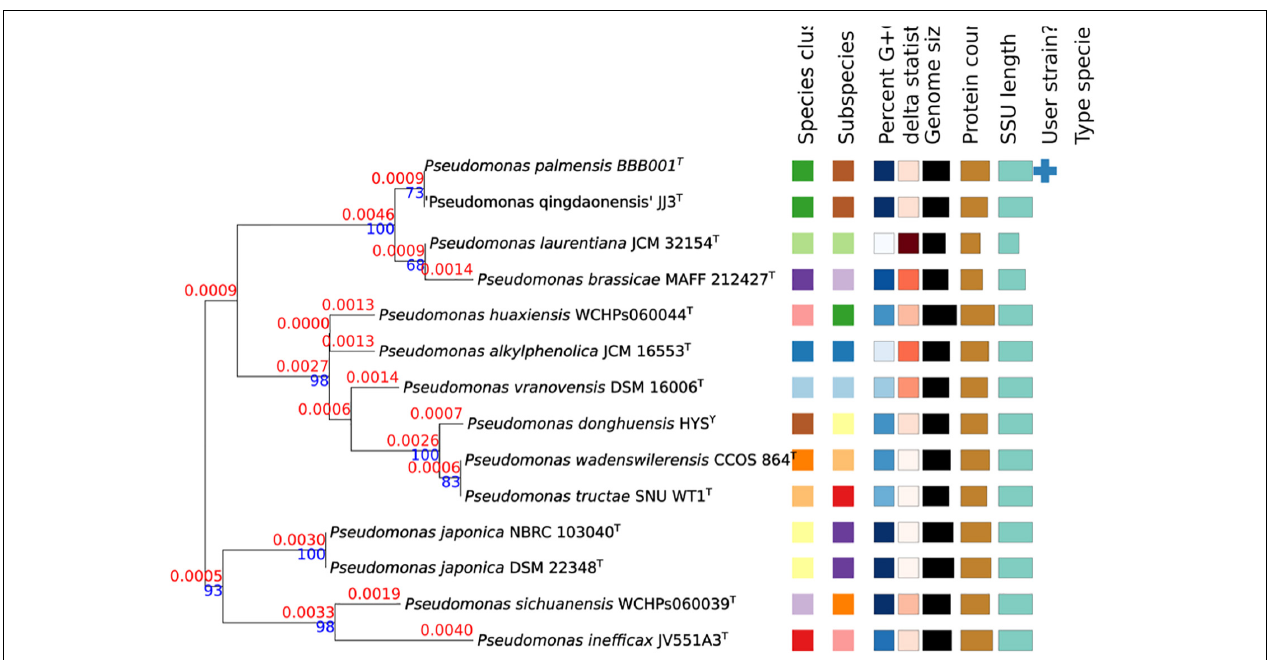
FIGURE 1 | Tree inferred with FastME 2.1.6.1 (Lefort et al., 2015) from GBDP distances calculated from 16s rRNA gene sequences. The branch lengths are scaled in terms of GBDP distance formula d5. The blue numbers are GBDP pseudo-bootstrap support values > 60% from 100 replications, with an average branch support of 80.9%. The branch length values (in red) represent the evolutionary time between two nodes. Unit: substitutions per sequence site. The tree was rooted at the midpoint (Farris, 1972).